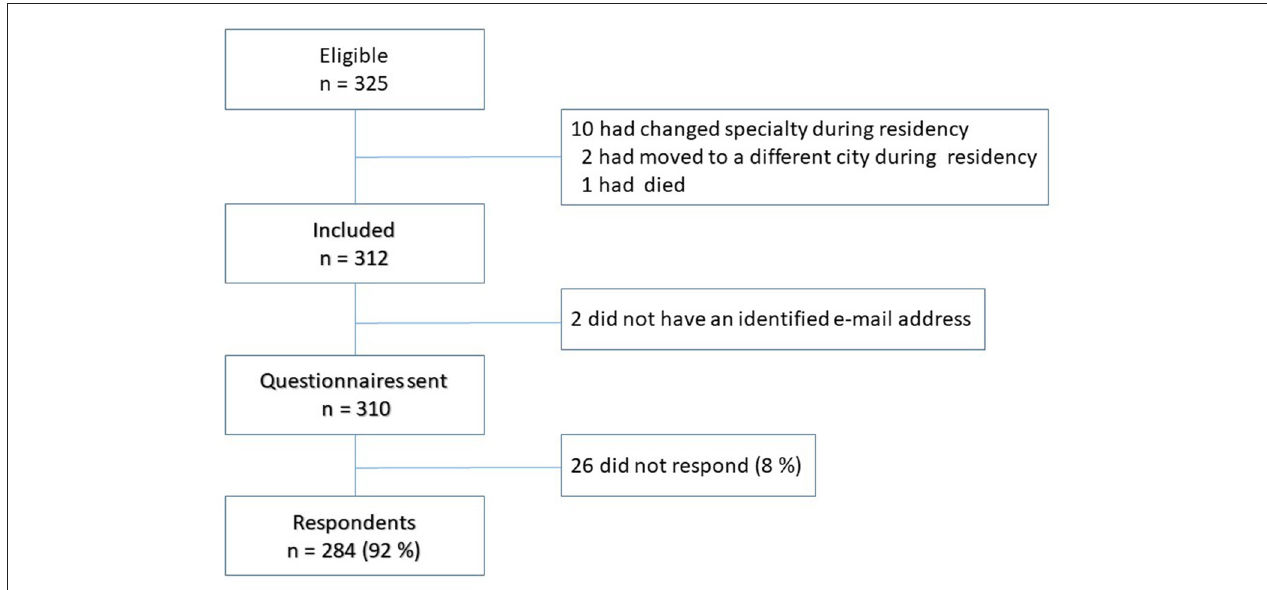
FIGURE 1 | Flow chart of study